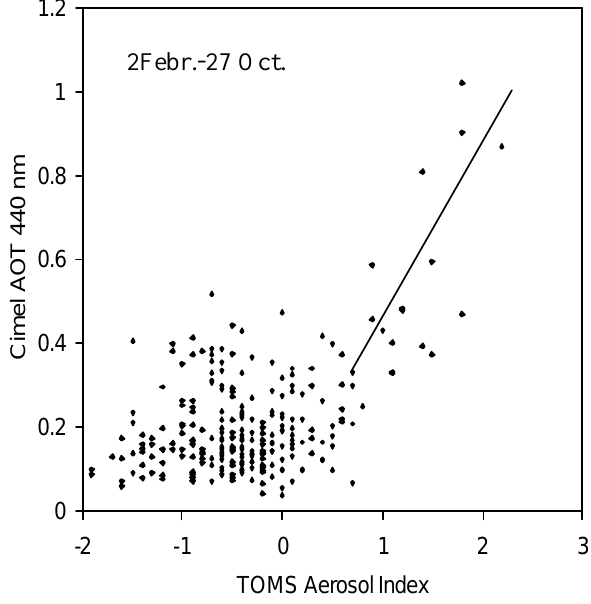
Fig. 3. AOD at 440nm versus and TOMS A.I. at El Arenosillo. A qualitative straight line is drawn for high A.I. and AOD